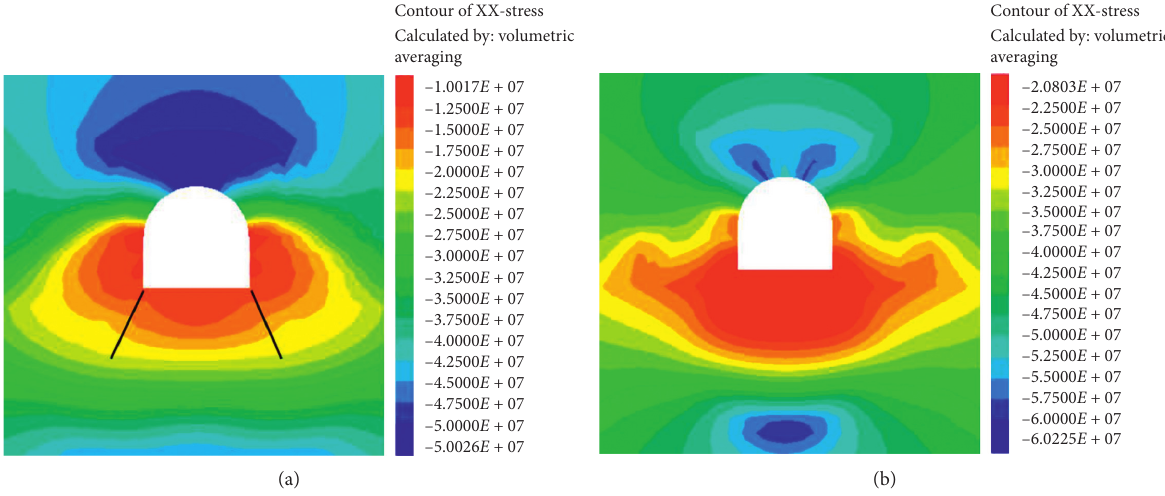
Figure 16: Horizontal stress cloud diagram of floor rock. (a) Floor for pressure relief and support (b) Floor without support.